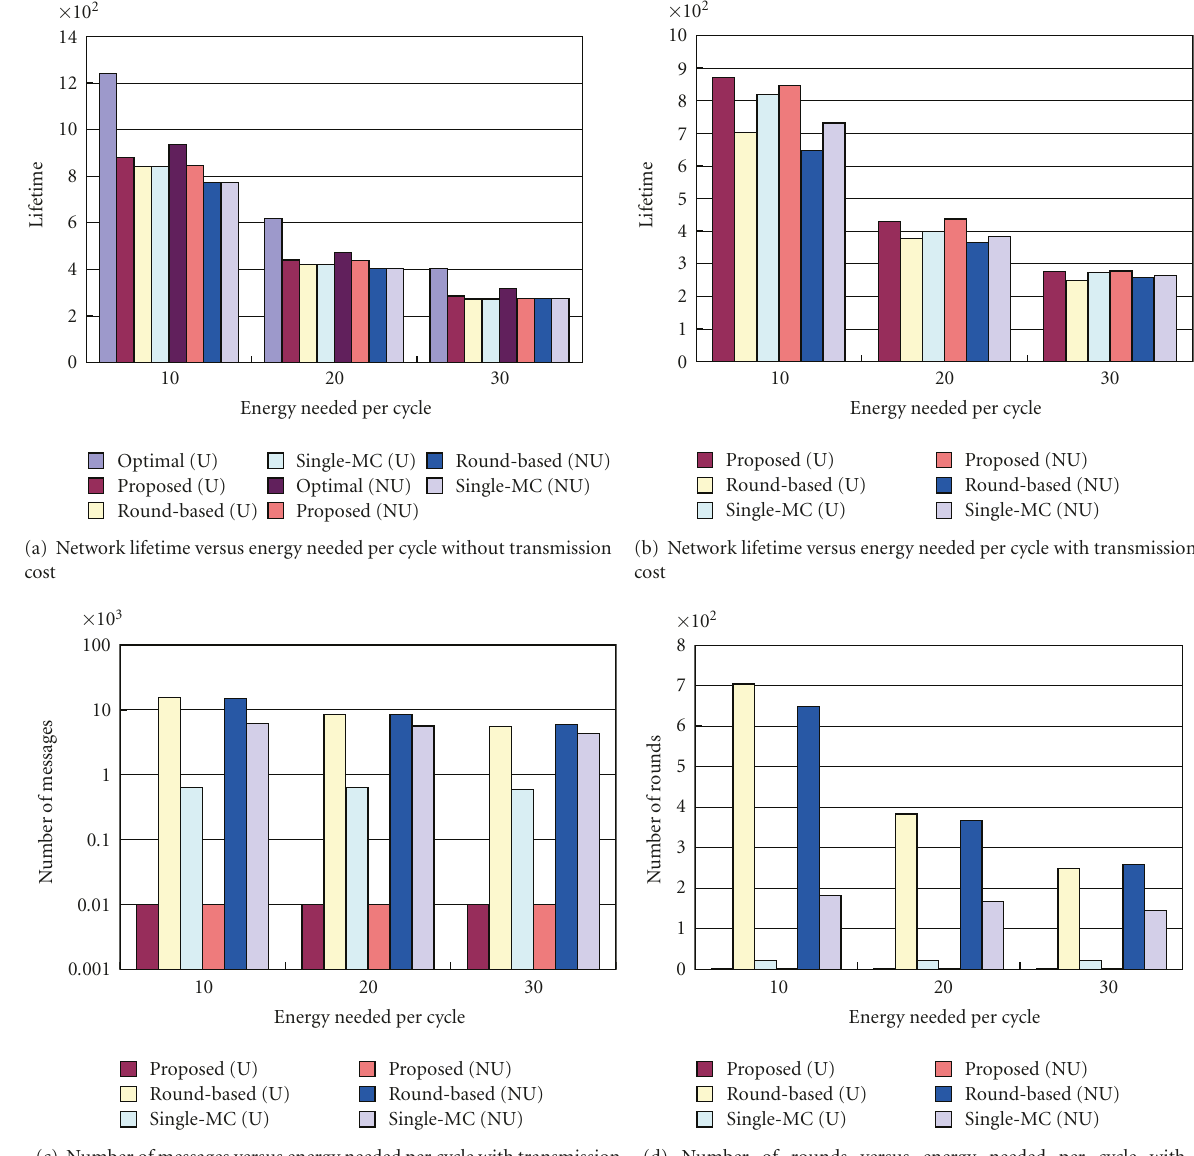
Figure 11: Varying energy needed per cycle